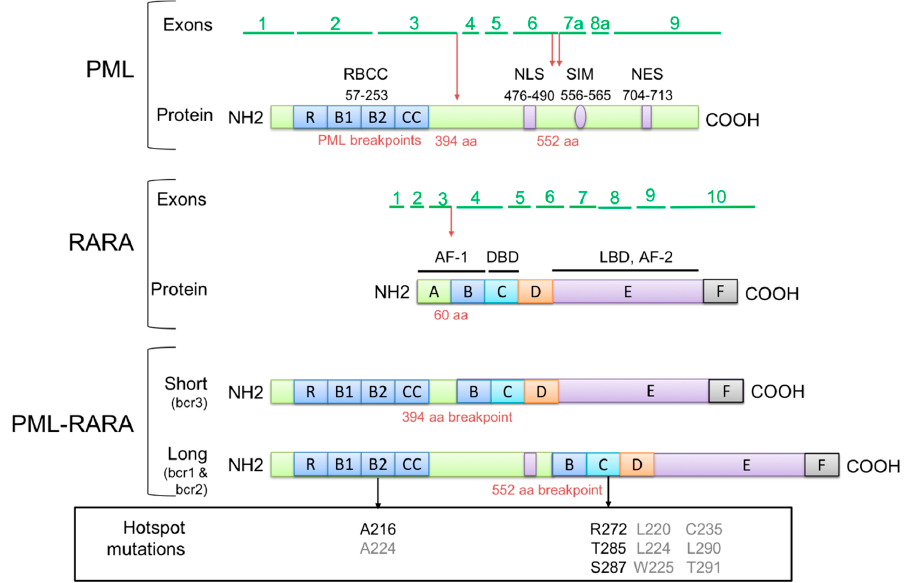
Figure 1. Structure of the acute promyelocytic leukemia (APL) primary event: promyelocytic leukemia (PML) and retinoic acid receptor- α (RARA) proteins and the corresponding PML–RARA fusion protein with the breakpoint regions (marked in red) and hotspot mutations (in the box at the bottom of the figure; in black are presented commonly mutated positions, and in grey rarer changes). In PML: RING finger (R), B boxes (B1 and B2), coiled-coil domain (CC), nuclear localization signal (NLS), SUMO-interacting motif (SIM), and nuclear export signal (NES). In RARA: N-terminal domain (A, B), including the activation function domain 1 (AF-1), DNA-binding domain (C), hormone-binding domain (E) and other regulatory domains (D and F).